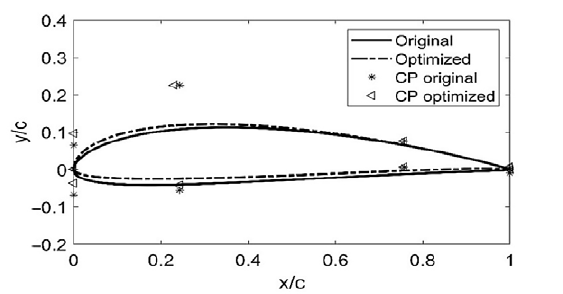
Figure 2. Airfoil